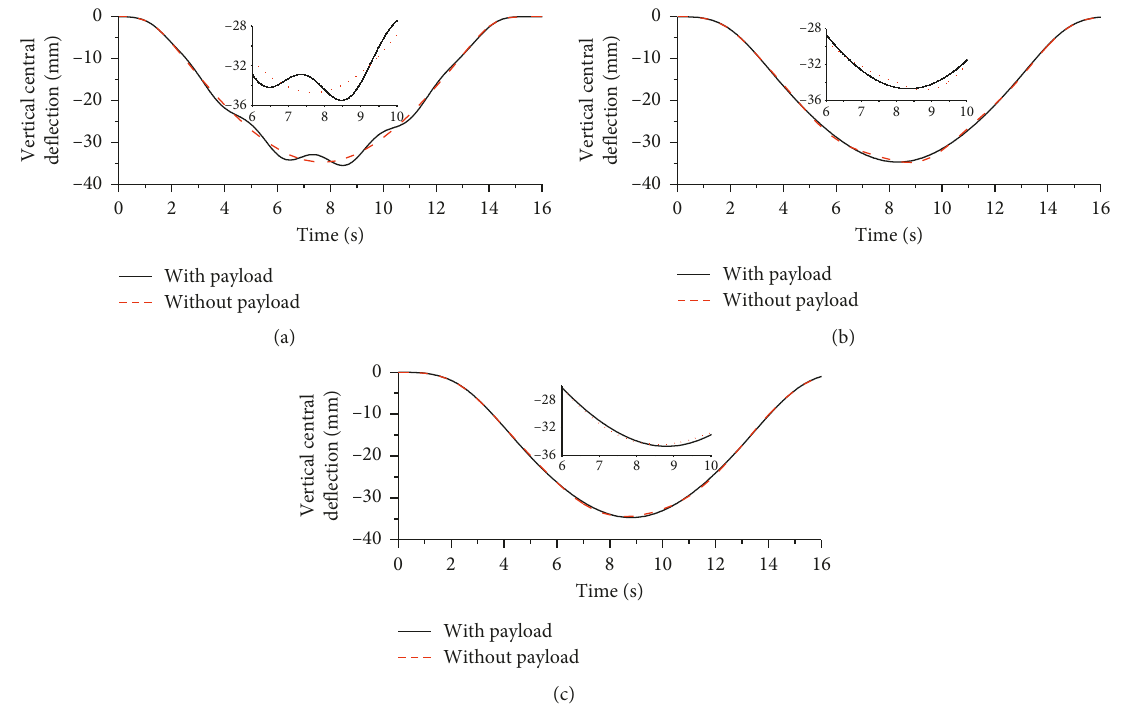
Figure 10: The deflection of a beam affected by payload swing: (a) when the cable length is 6m; (b) when the cable length is 14m; (c) when the cable length is 22